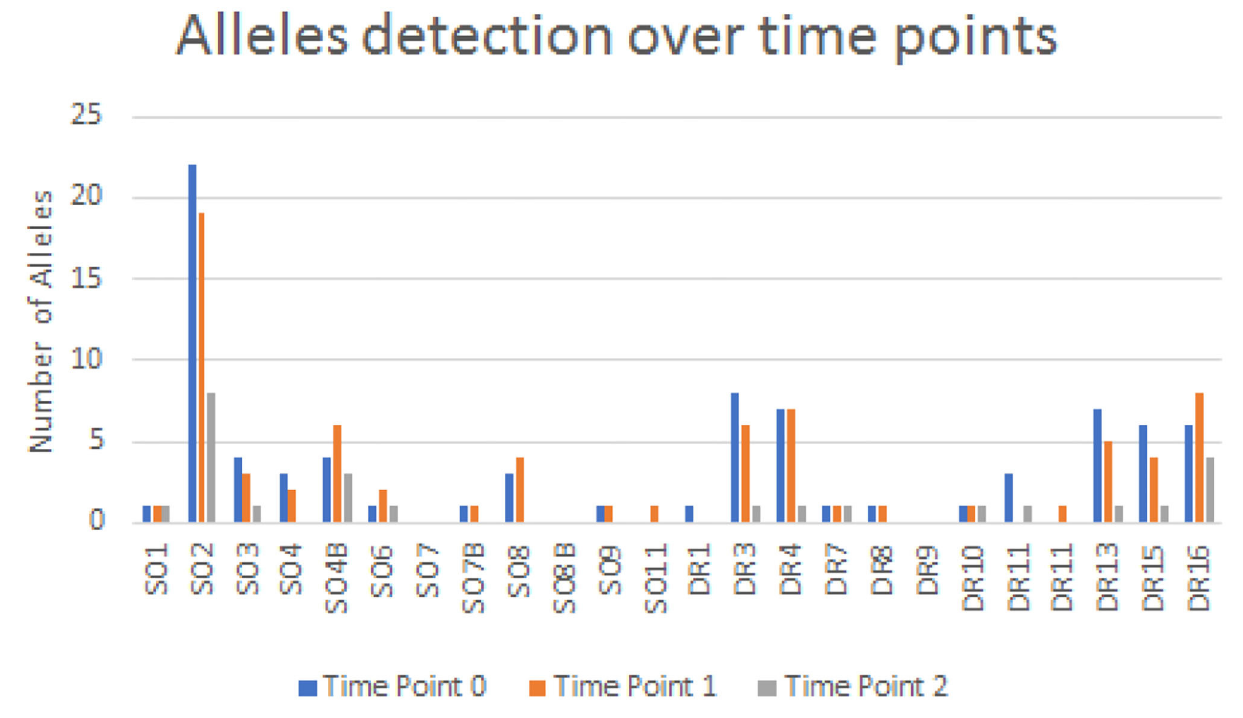
FIGURE 3 | Descriptive diagram for allele detection over